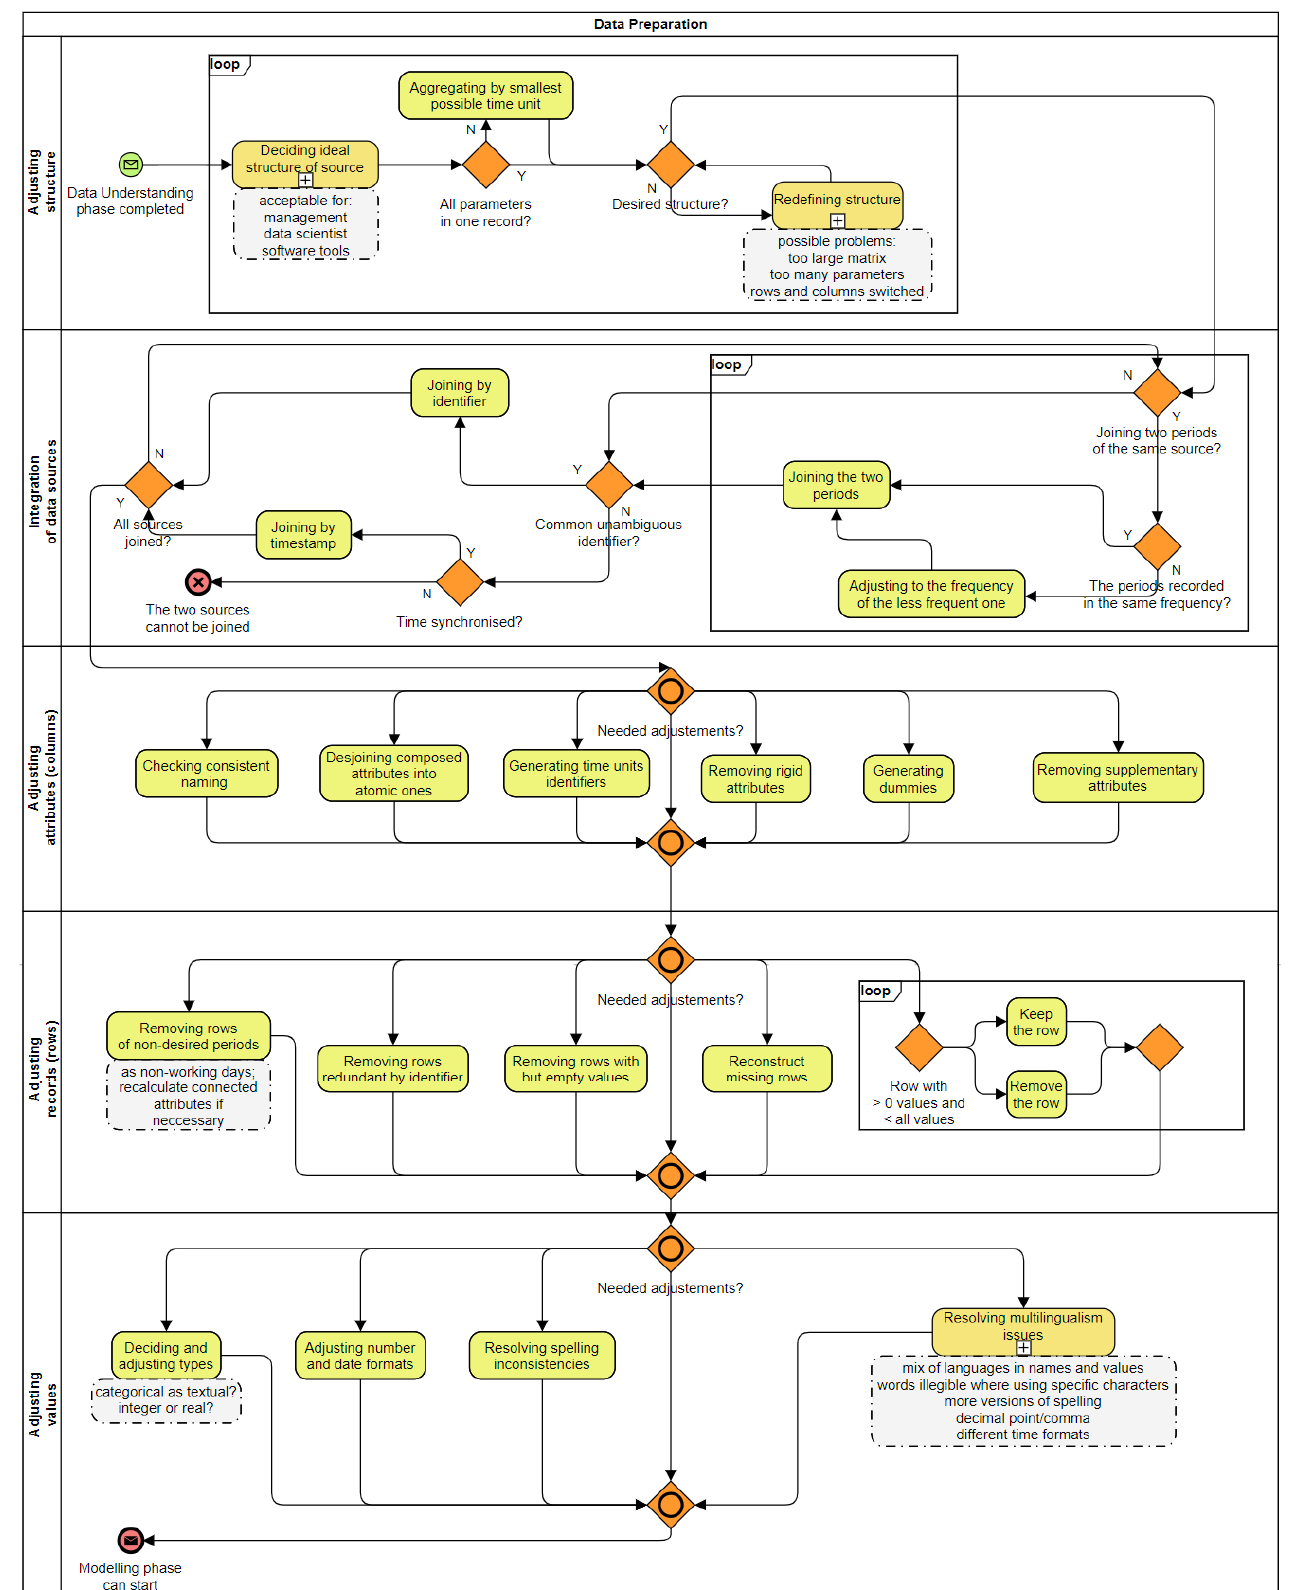
Figure 2. Detailed diagram proposal for the ‘Data Preparation’